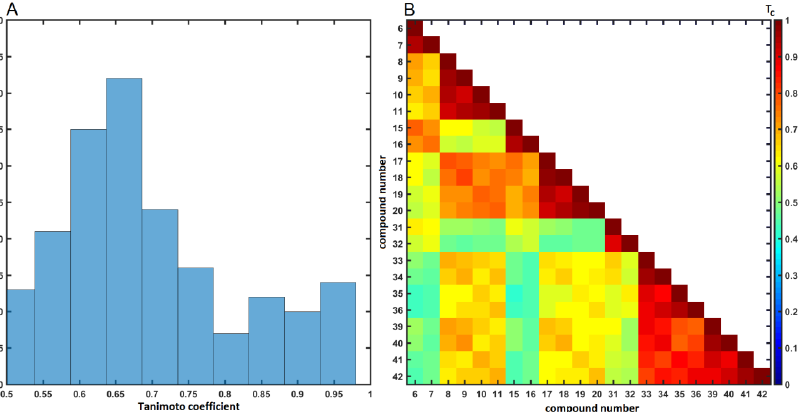
Figure 12. Distribution of T c coefficients ( A ) and triangular matrix of Tanimoto coefficients ( B ) for carborane conjugates.